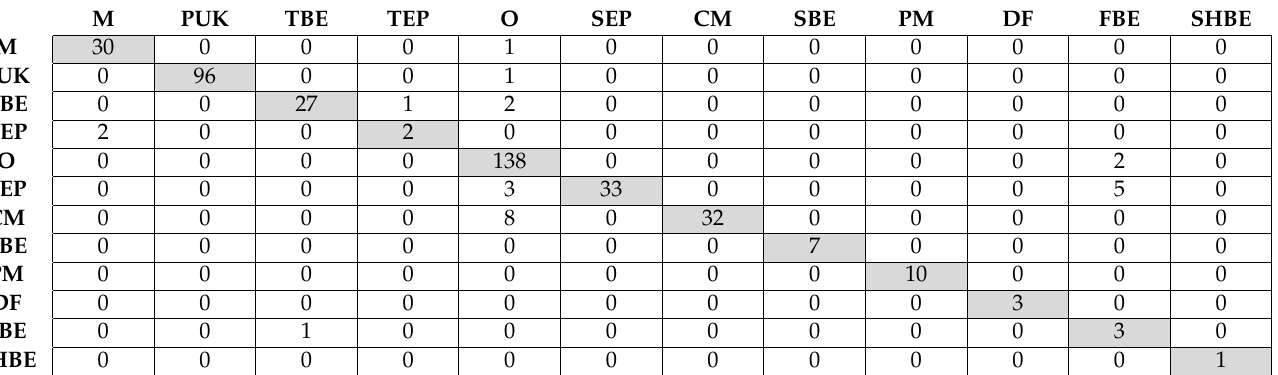
Table 5. Confusion matrix of HMM